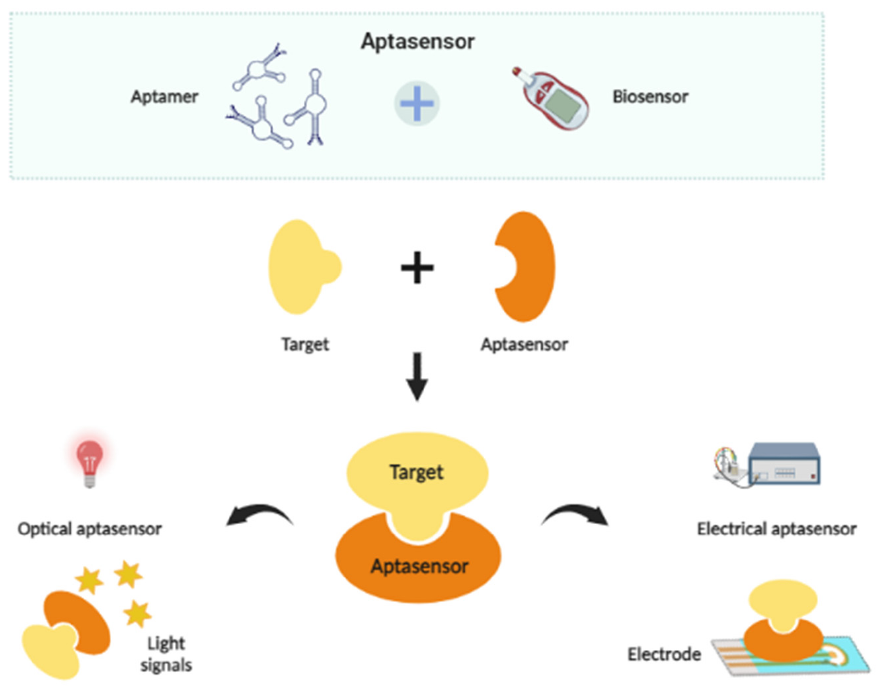
Figure 3. Simple principle of an aptasensor. (Created in BioRender.com, accessed on 9 September 2022).